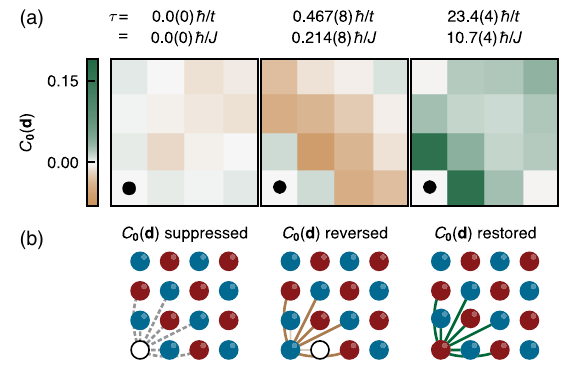
FIG. 4. Reversal and recovery of antiferromagnetic correla- tions. (a) Sign-corrected spin correlations C 0 ð d Þ from the initial hole location (black circle) at select times, symmetrized across reflections. Within one tunneling time, we observe antiferromag- netic correlations but with the opposite sign (light brown), apart from the nearest-neighbor correlator. The correct AFM pattern (green) then slowly restores itself, although the correlations have not fully equilibrated even at our longest measured times, τ ¼ 23 . 4 ð 4 Þ ℏ =t ¼ 10 . 7 ð 4 Þ ℏ =J [21]. (b) The emergence of short- time antiferromagnetic correlations with the opposite sign can be understood in a classical N´eel state. Initially, the hole swaps a neighboring spin to the origin, producing reversed correlations at the origin site. At later times, relaxation processes restore the correct